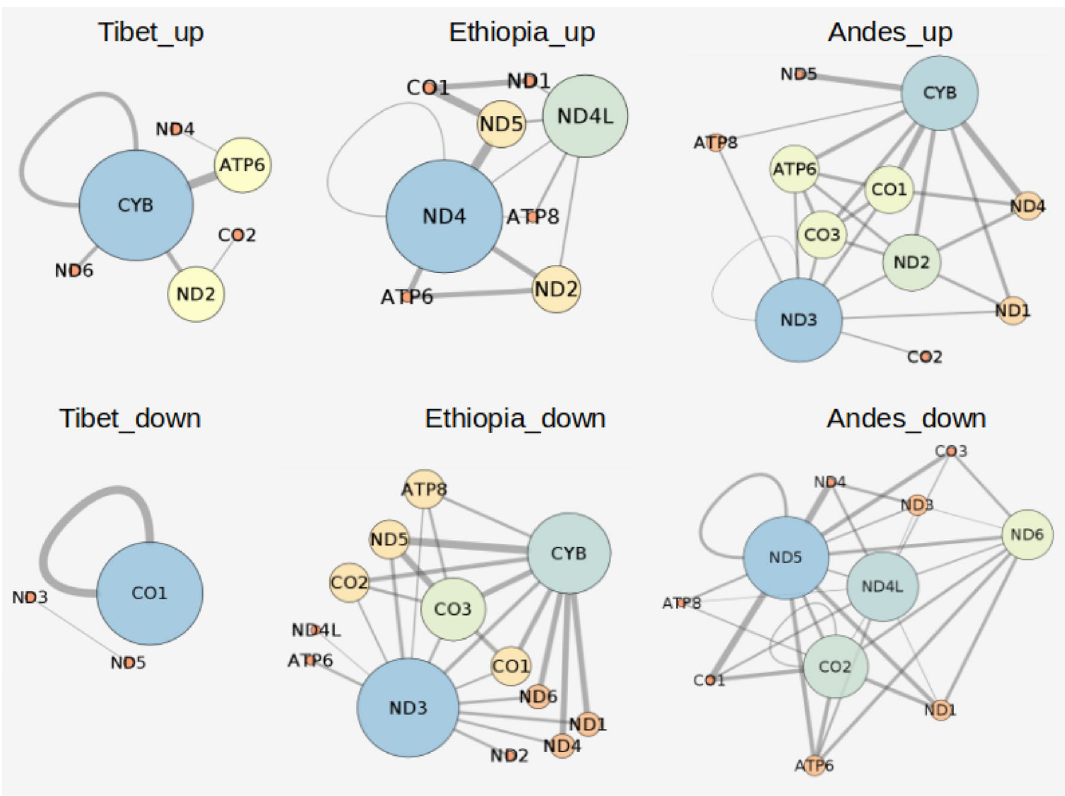
Figure 6. Significant gene–gene interactions of exclusive nodes co-mutations. The Region_up and Region_ down represents those interactions which were showing higher and lower weight than the corresponding random networks for each region, respectively (the node size depicts the degree of the node and edge size represents the edge